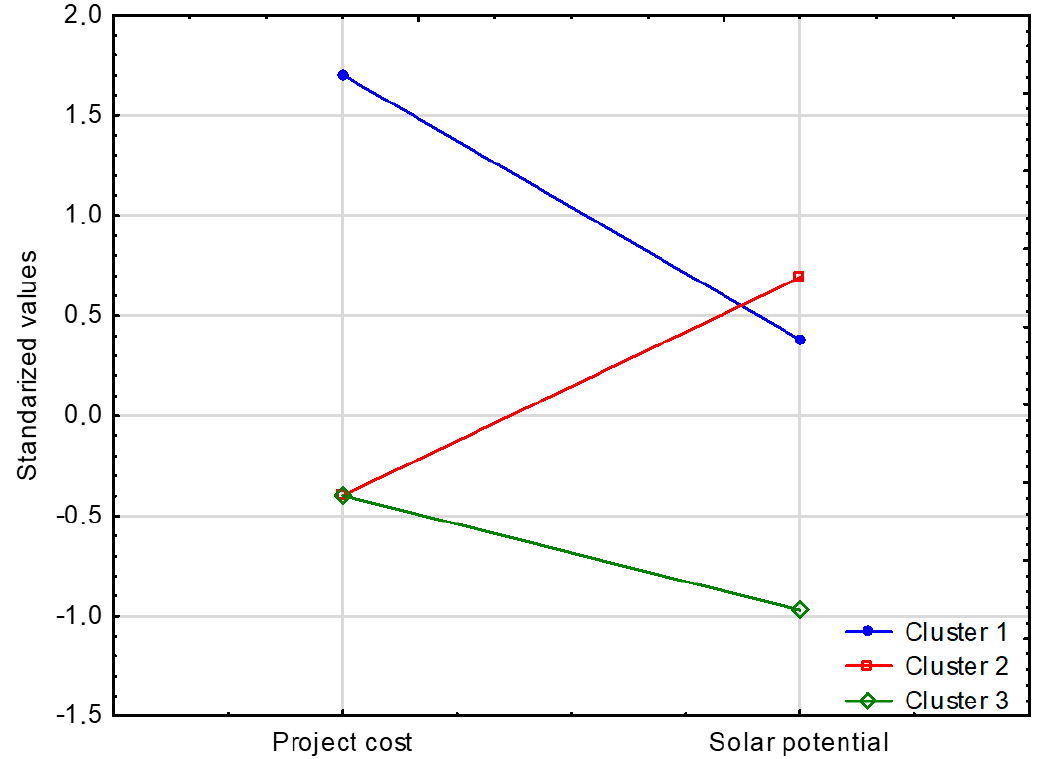
Figure 1. Standardized average project costs and solar potential.